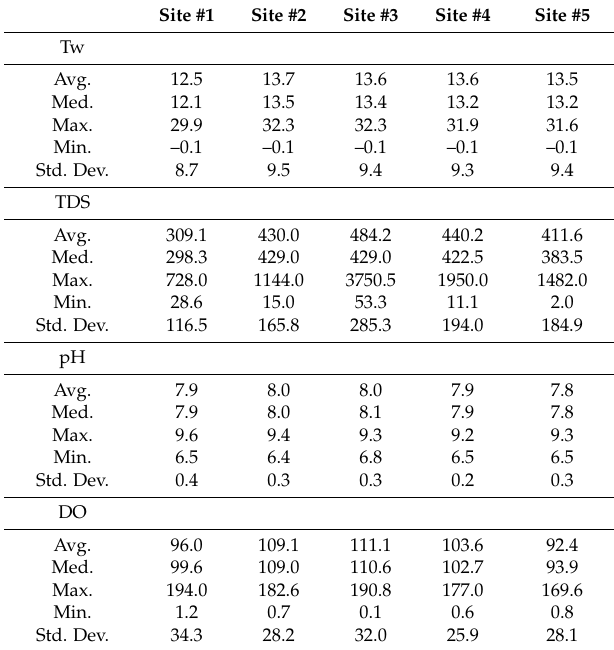
Table 4. Descriptive statistics for water temperature (Tw) ( ◦ C), total dissolved solids (TDS) (mg L − 1 ), pH, and dissolved oxygen (DO, % of saturation) at each gauging site ( n = 5) during study period (October 2010–May 2014) in Hinkson Creek Watershed, MO,